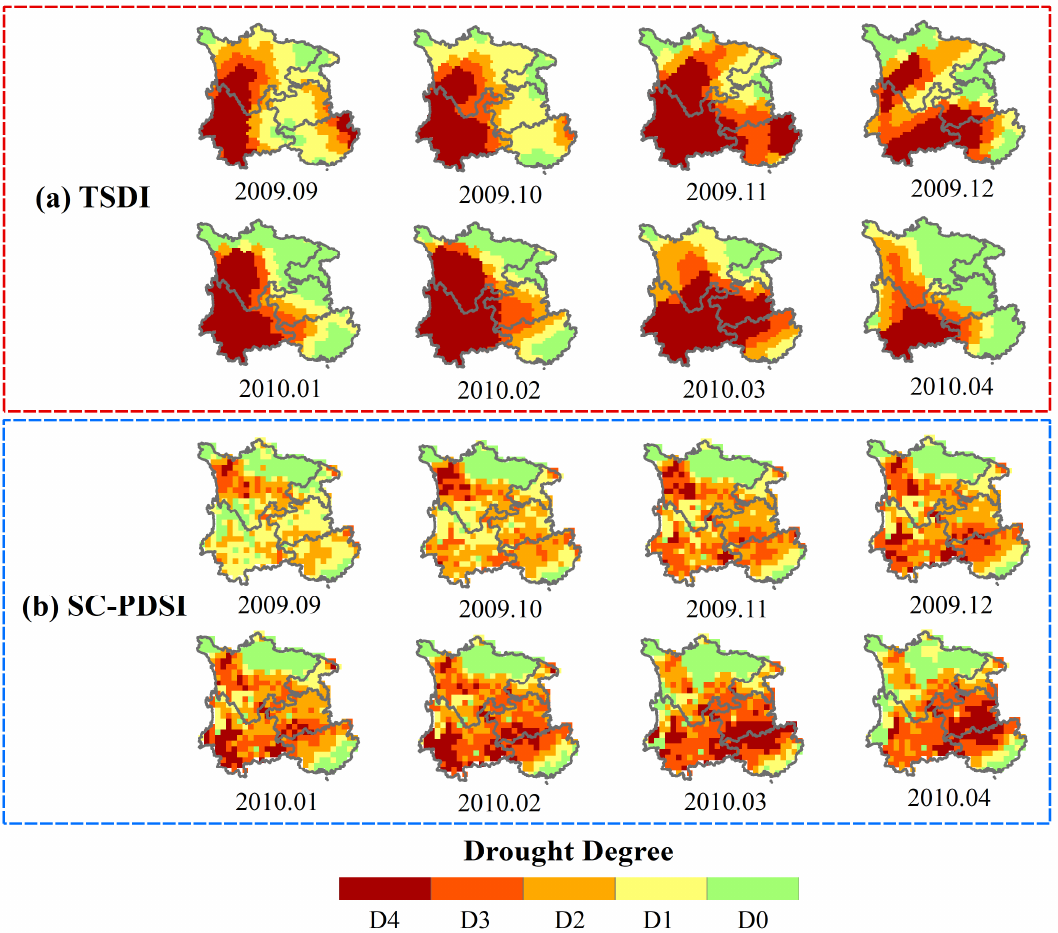
Figure 7. Spatial distribution of drought during 2009.09–2010.04 in Southwest China. ( a ) TSDI, ( b ) Self-calibrating Palmer drought severity index.